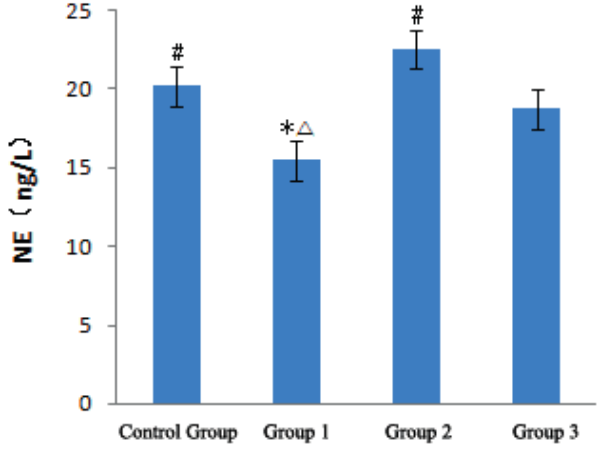
Figure 3. Analysis of NE in ApoE − / − mice. Compared with the control group, * p < 0.01; Compared with the heat wave group, # p < 0.01; Compared with the temperature drop group, △ p <